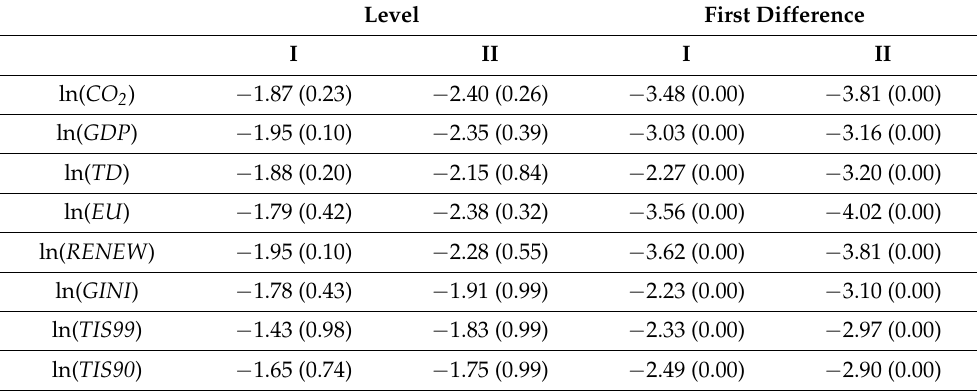
Table 2. Results of CADF unit root test.